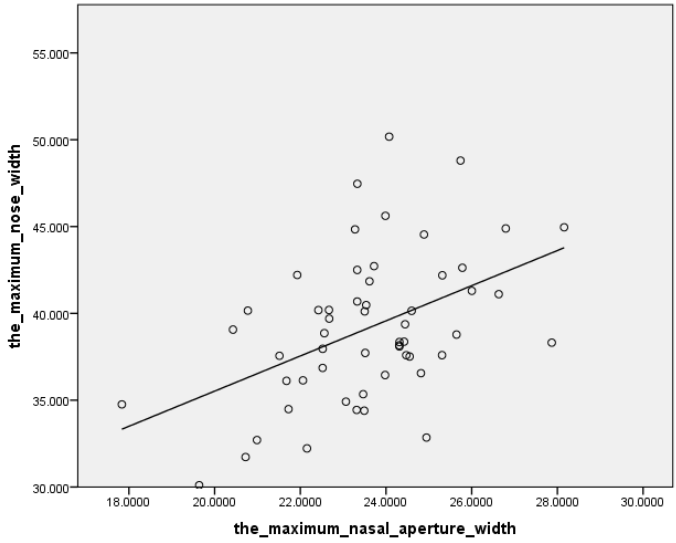
Figure 4. Regression plot.